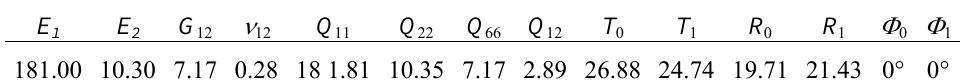
Table 2. Technical, Cartesian and polar constants of carbon-epoxy T300-5208 plies